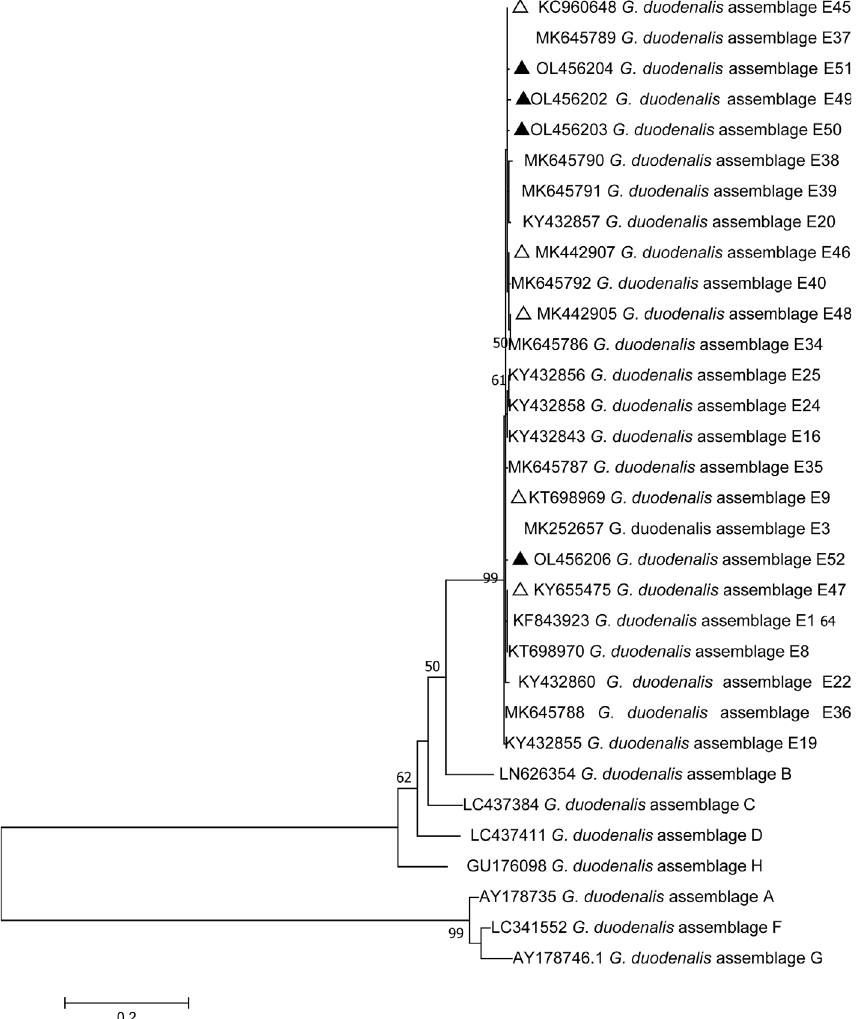
Figure 3. Phylogenetic relationships of glutamate dehydrogenase ( gdh ) nucleotide sequences of G. duodenalis assemblages (A – H) and assemblage E subtypes, using the maximum composite likelihood model. Percent bootstrap values greater than 50% from 1000 replicates are shown next to the branches. The black triangles and hollow triangles represent published and novel isolates in this